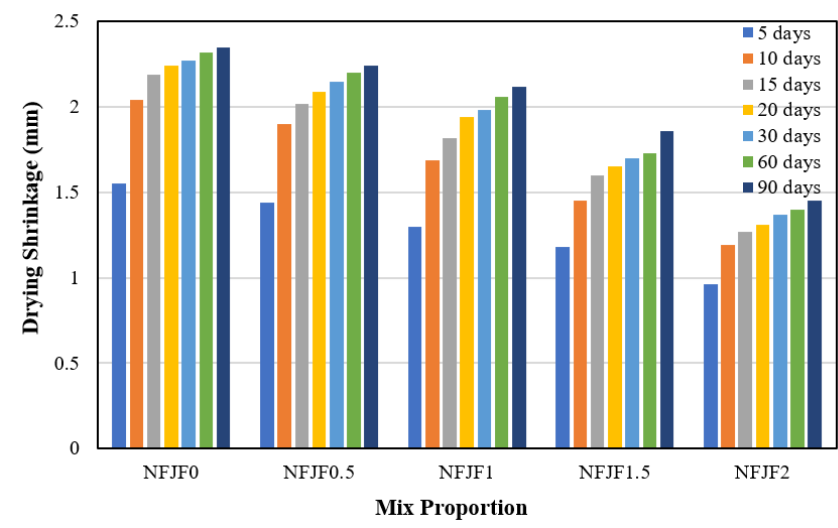
Figure 11. Drying shrinkage of concrete.